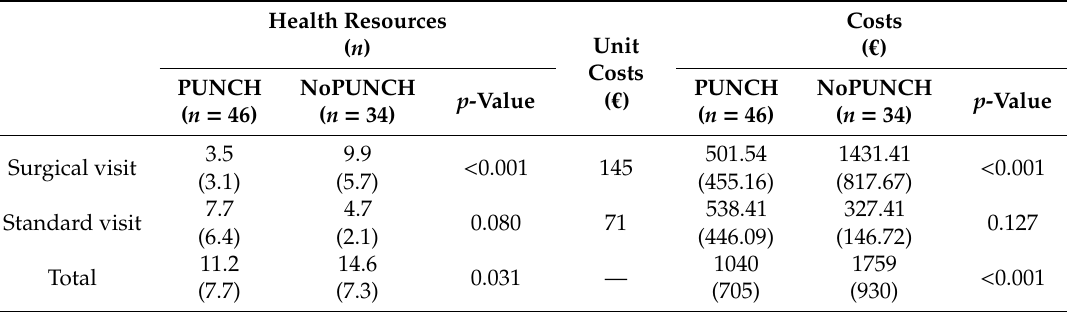
Table 2. Health resources, unit costs, and health